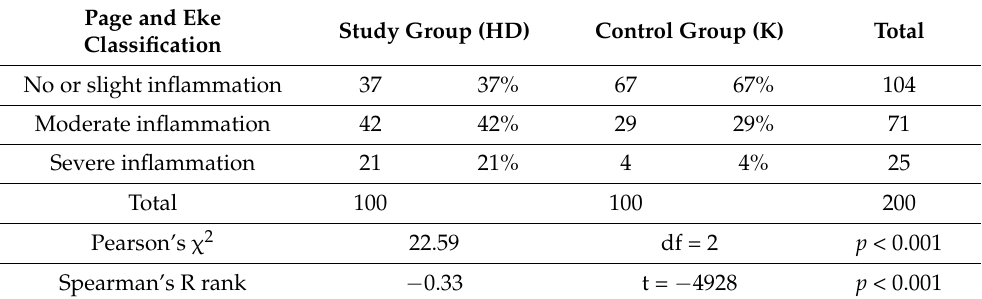
Table 6. Diagnosis of periodontitis according to Page and Eke [27] in the study groups (HD, K). Page and Eke Study Group Classification